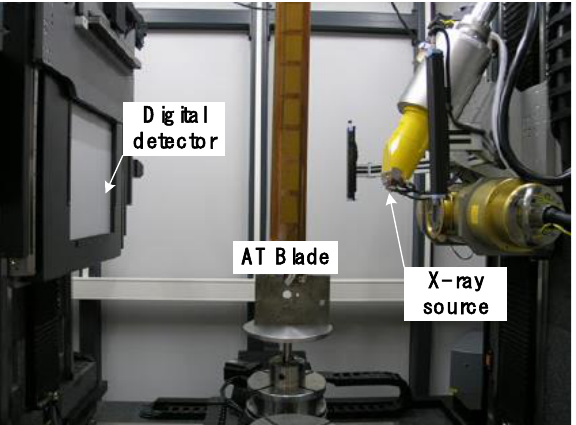
Figure 2. AT blade setup installed for X-ray CT scan (blade placed in the cardboard container).